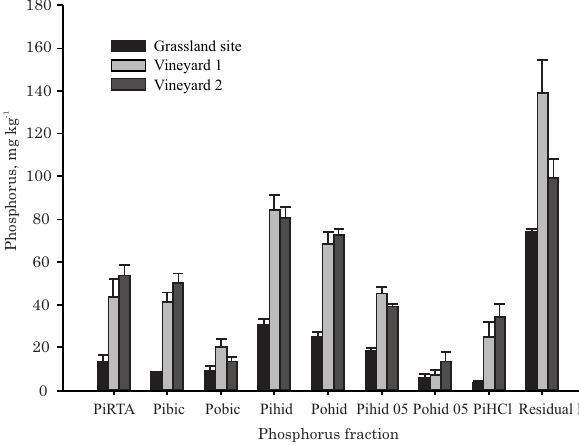
Figure 1. Sum of the P content of different fractions in the three layers, in a sandy Typic Hapludalf soil under native grassland and of vineyard 1 (age 14 years) and vineyard 2 (age 30 years). Pi RTA , inorganic P extracted by anion-exchange resin; Pi bic and Po bic : inorganic and organic P extracted by 0.5 mol L -1 NaHCO 3 ; Pi hid and Po hid : inorganic and organic P extracted by NaOH 0.1 mol L -1 Pi hid05 and Po hid05 : inorganic and organic P extracted by NaOH 0.5 mol L -1 ; Pi HCl , inorganic P extracted by 1 mol L -1 HCL; P residual , P extracted by H 2 SO 4 +H 2 O 2 +MgCl 2